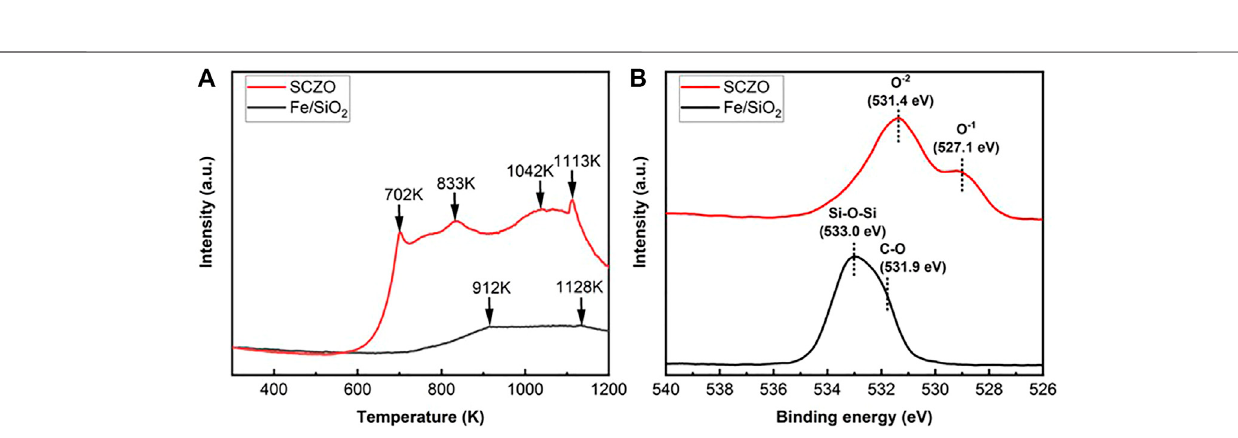
FIGURE 2 | H 2 -TPD pro fi les (A) and XPS spectra of O1s photoelectron lines (B) of Fe/SiO 2 catalyst and SCZO perovskite oxide